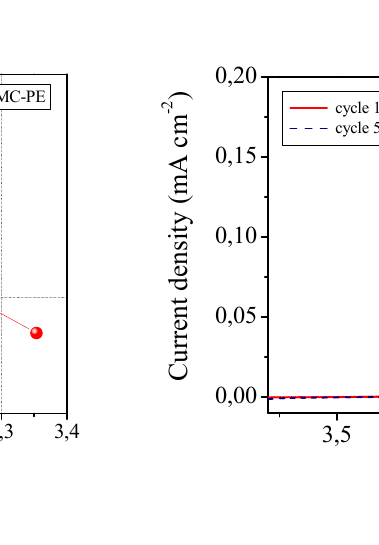
Figure 7. ( a ) Ionic conductivity versus temperature plot of the MC-PE reinforced quasi-solid polymer electrolyte. Data obtained by impedance spectroscopy; ( b ) Current vs . voltage curves at room temperature for